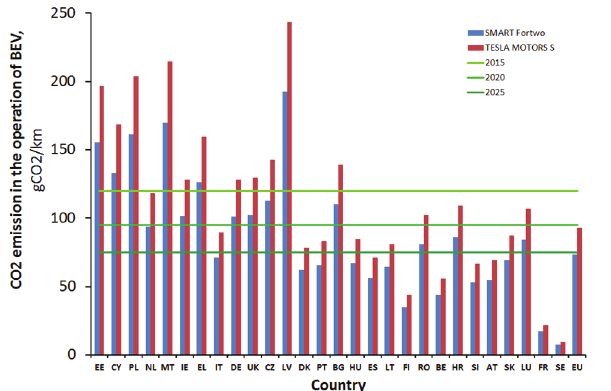
Fig. 5. CO 2 emission in the operation of BEV’s in countries of EU and also average for EU For the comparison in Figure 5 are the maximum emis- sion of CO for car fleets in EU for next year’s showing. 2 These values are correct for NEDC but for the WLTP test they are only slightly